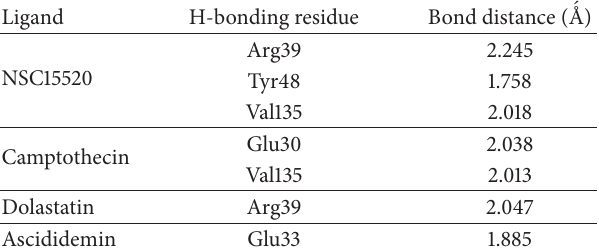
Table 3: RAD9 and ligands interacting